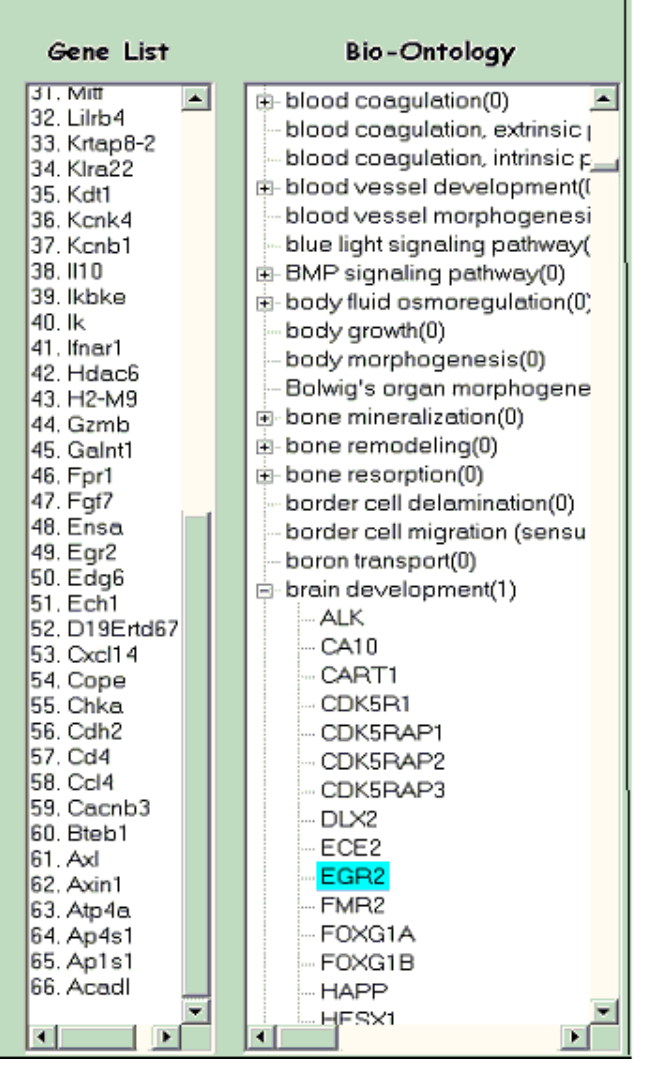
Figure 2. The Bio-Ontology hierarchy. The genes highlighted within the Bio-Ontology are those from the imported microarray gene list. The gene, EGR2 has functionality in brain development. The un-highlighted genes are also known to be involved in brain development, but are not found within the imported microarray gene